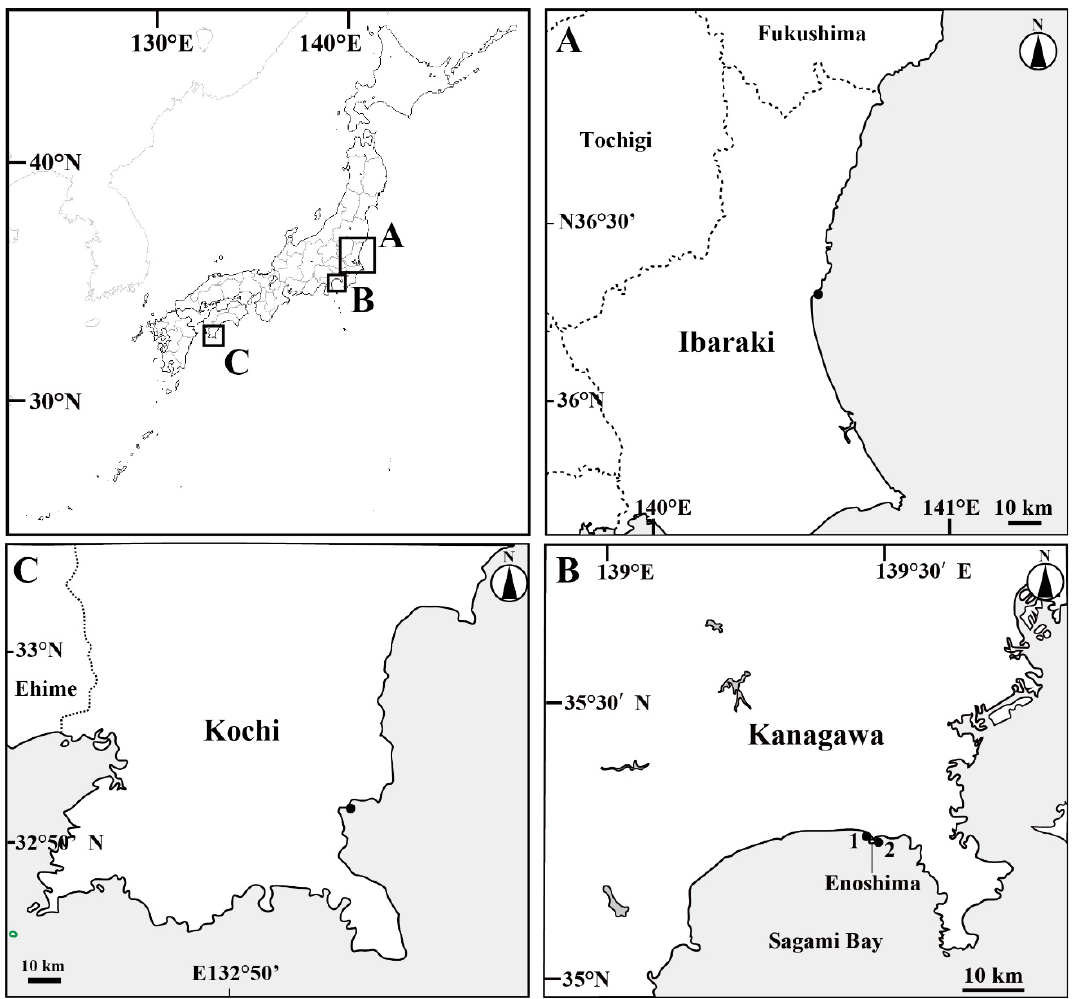
Figure 1. Map of the sampling sites. ( A ) Oarai Fishing Port, Higashi-Ibaraki, Ibaraki Prefecture; ( B ) Enoshima, Fujisawa, Kanagawa Prefecture: (1) Katase Fishing Port, (2) Enoshima; ( C ) Shimonokae Fishing Port, Tosashimizu, Kochi Prefecture. Black closed circles are sampling sites.